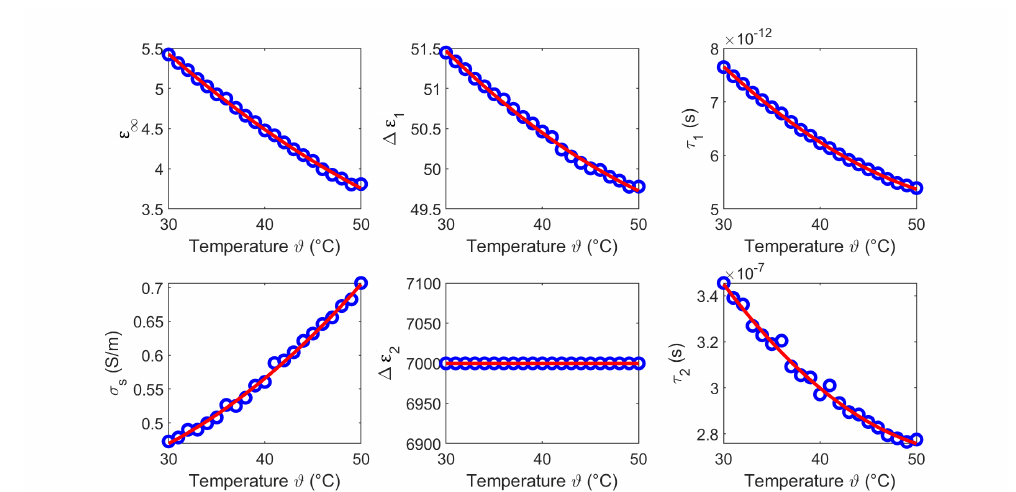
Figure 10. Temperature dependent Cole-Cole parameters (blue circles) of muscle and the corresponding second order polynomial fit (red curves).